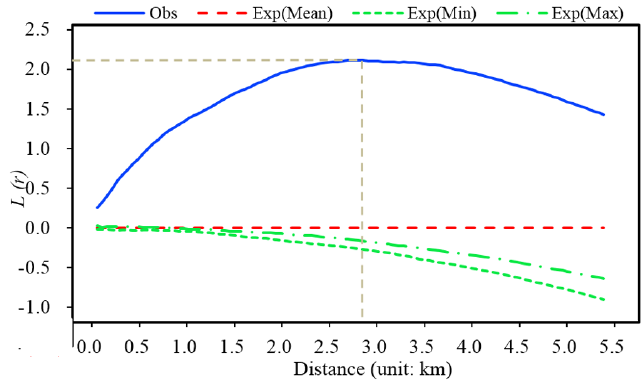
Figure 5. L-function of karaoke bars.